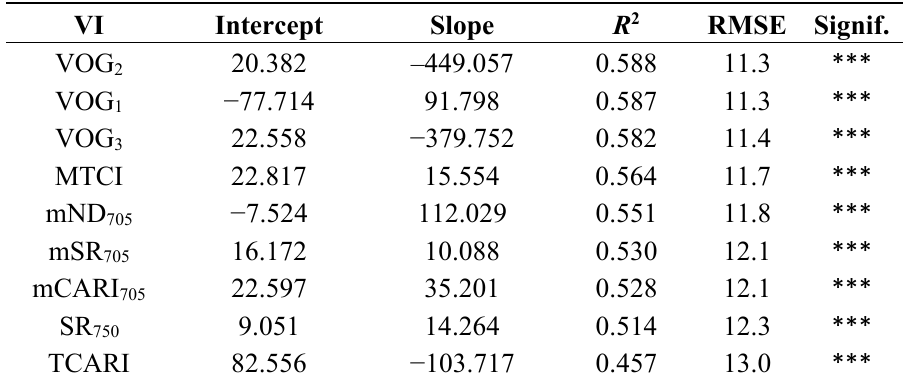
Table 2. Relationship between CC and VIs ( n =